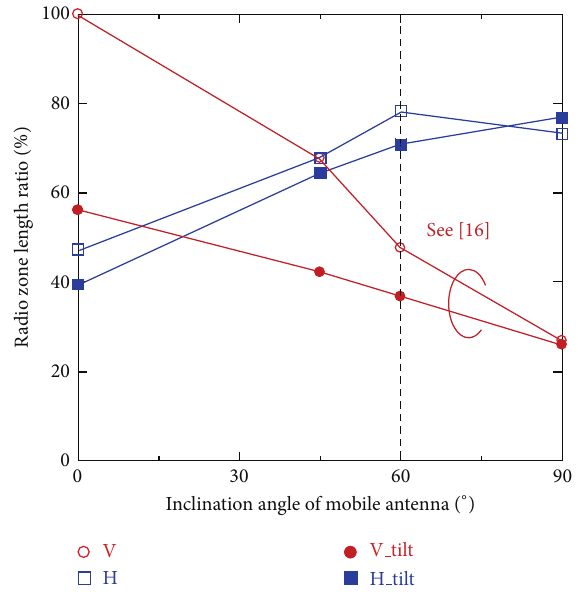
Figure 20: RZLR versus inclination angle of mobile antenna.